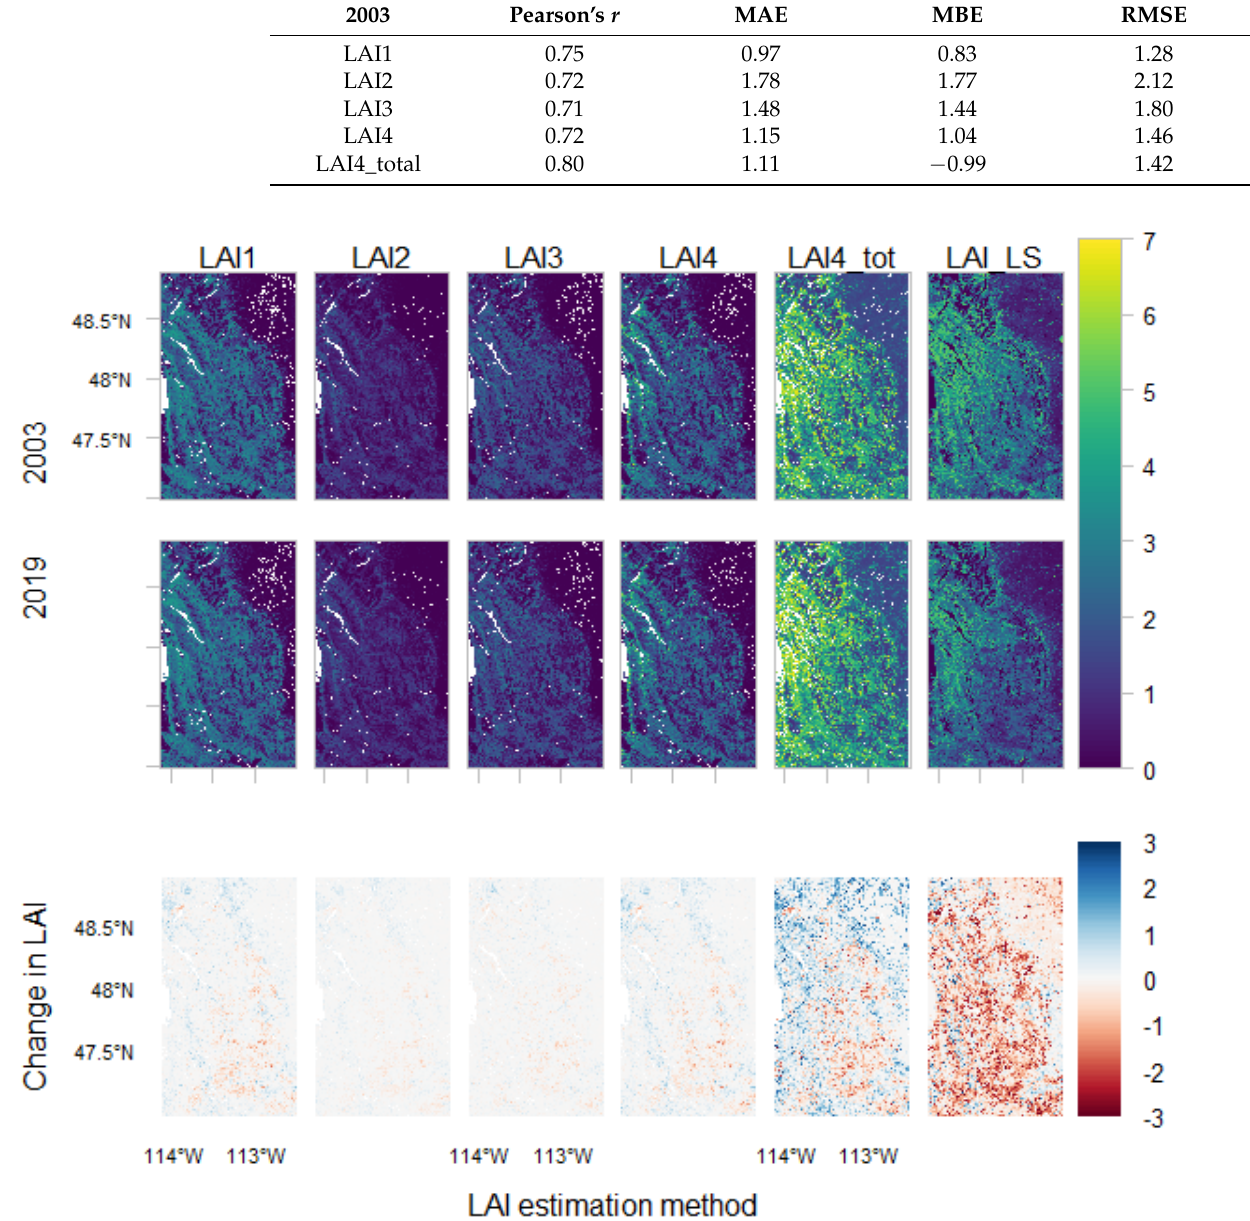
Figure 5. Maps of LAI based on random forests interpolations of empirical plot-based methods (LAI1, LAI2, LAI3, and LAI4 for overstory LAI; LAI4_tot for overstory + understory LAI), and Landsat total LAI (LAI_LS) for 2003 and 2019 (top and middle rows, respectively) and for the difference between 2003 and 2019 (bottom row) for the entire modeling domain shown in Figure 1. Negative change represents decreases in LAI.